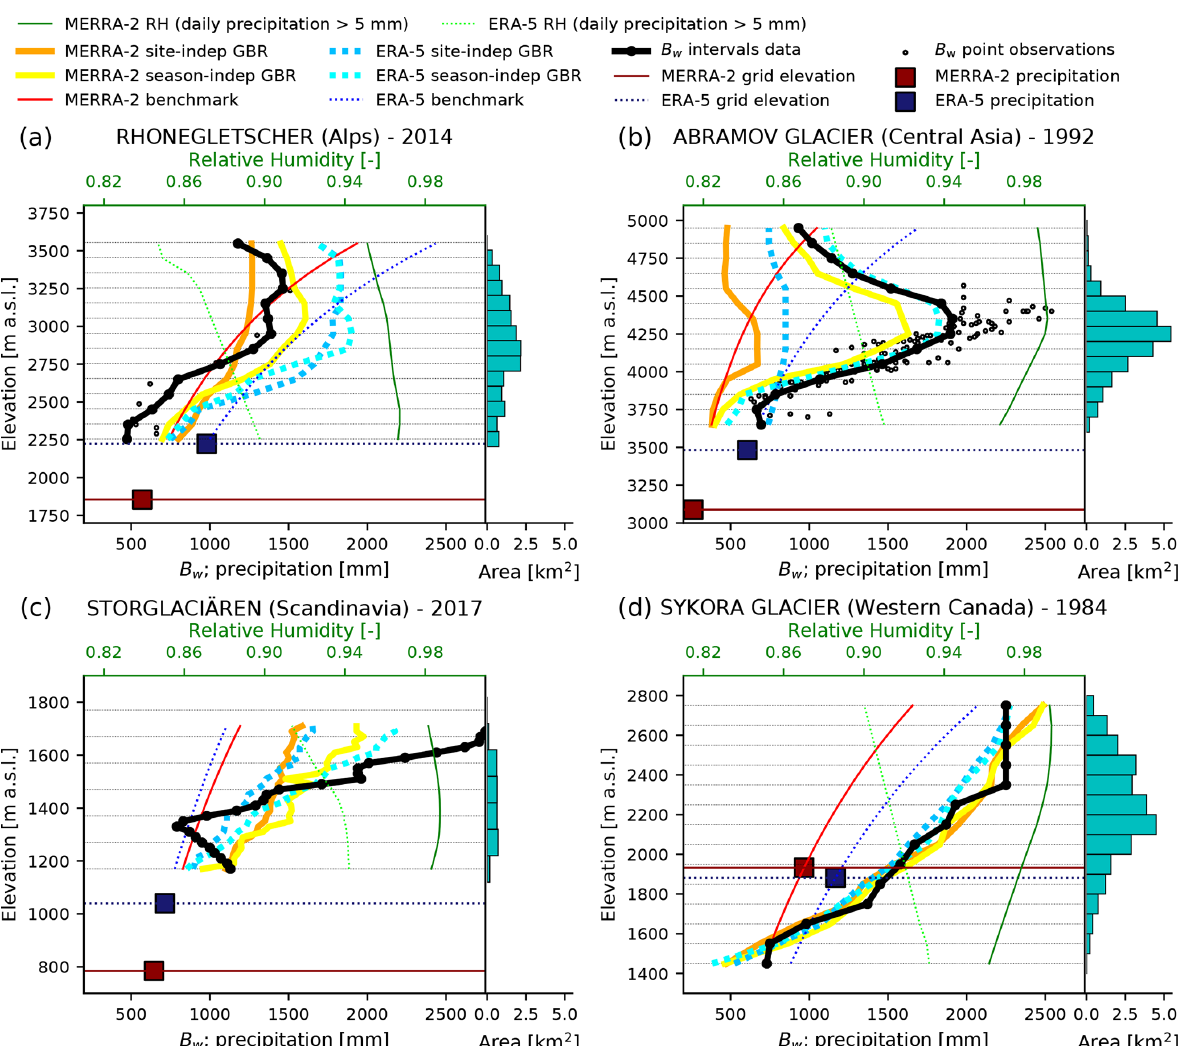
Figure 7. Vertical profiles of B w at the end of a specific accumulation season: (a) Rhonegletscher (Alps), (b) Abramov glacier (Central Asia), (c) Storglaciären (Scandinavia) and (d) Sykora glacier (western Canada). RH refers to the average relative humidity during days with a minimum precipitation of 5mm. Note that the scale of the y axis differs between the